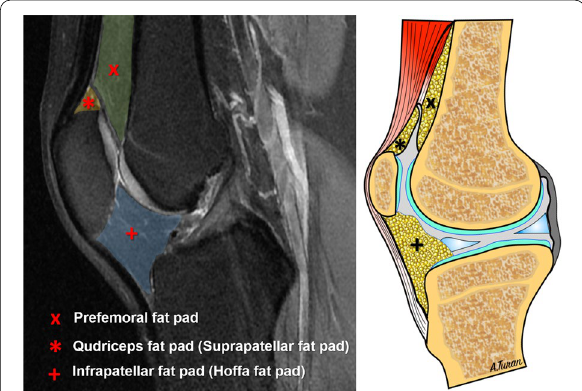
Fig. 1 Sagittal fat-saturated, proton-density-weighted MRI image and corresponding illustration showing the location of the fat pads on the anterior aspect of the knee joint